Question: Express in one sentence what the figure is showing.
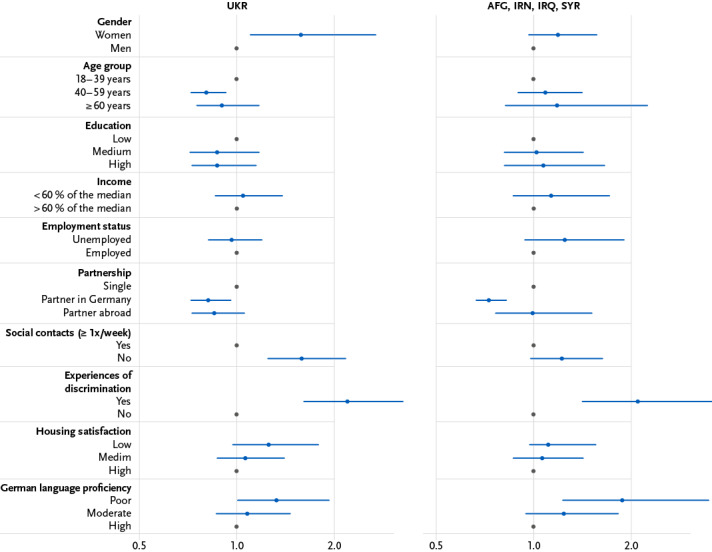
Answer: Determinants of anxiety symptoms (GAD-2) among refugees from Ukraine (n = 2,869) and those from Afghanistan, Iran, Iraq, and Syria (n =1,457). Results of Poisson regression models (prevalence ratios). Source: IAB-BAMF-SOEP Survey of Refugees 2023 UKR = Ukraine, AFG = Afghanistan, IRN = Iran, IRQ = Iraq, SYR = Syria